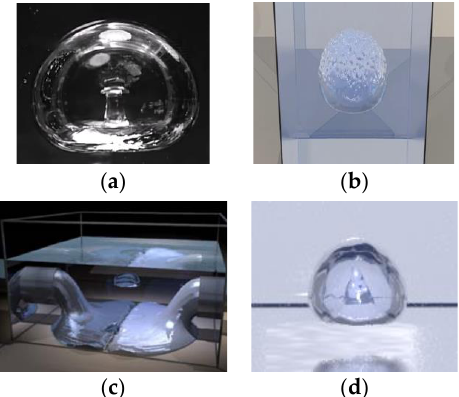
Figure 9. Comparison of the bubble movement effect of real picture with the three methods. ( a ) real picture, ( b ) reference [28], ( c ) reference [23], ( d ) this paper. Experiment 4. Figure 10 shows the bubble effect under different dynamic viscosity coefficients. The viscous force of the liquid hinders the upward movement of the bubble, and the bubble transforms from a spherical shape to an ellipsoid shape. Except for the jet generated on the lower surface due to inertia and viscous force, the surface is subject to a slight oscillation deformation. It can be observed that the larger the dynamic viscosity coefficient, the greater the surface deformation. ( a ) μ = 0.8 ( b ) μ = 1.2 Figure 10. Comparison of different viscosity coefficients.